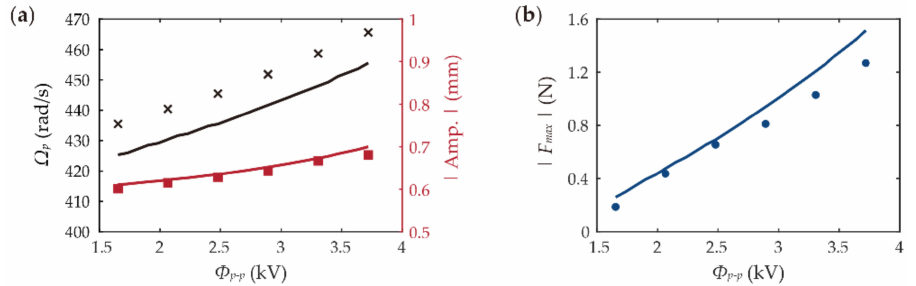
Figure 8. Experimental and modelling results on the effects of excitation voltage amplitude on ( a ) peak frequency and oscillation amplitude and ( b ) peak impact force. The discrete markers represent the experimental data and the continuous curves are the modelling results.